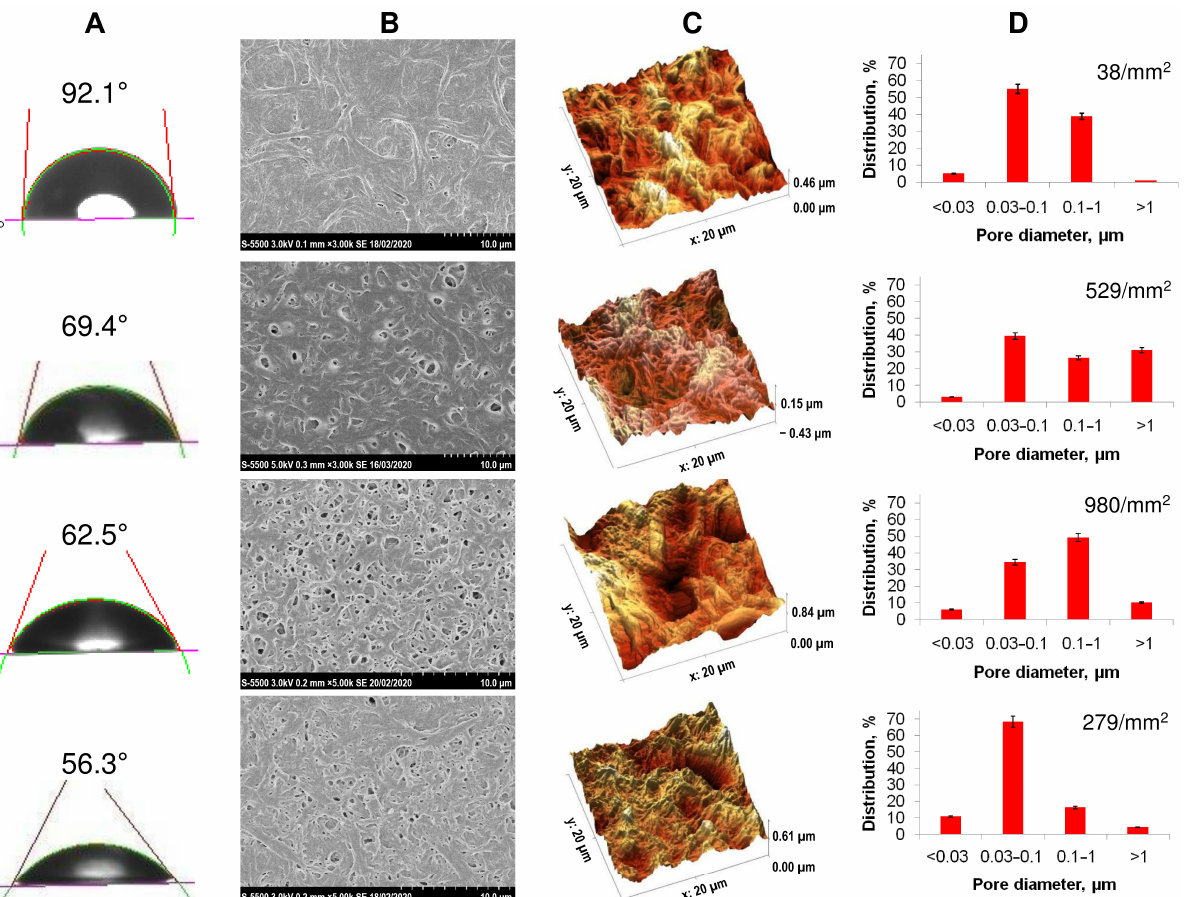
Figure 2. Solvent-cast PHA films’ characteristics: ( A )—water contact angle, ( B )—SEM image, ( C )—roughness (AFM), ( D )—porosity, where ( a )—P(3HB), ( b )—P(3HB-co-27 mol.% 3HV), ( c )—P(3HB-co-35 mol.% 4HB), ( d )—P(3HB-co-38 mol.% Table 2. Surface properties of solvent-cast films prepared from PHAs with different compositions.